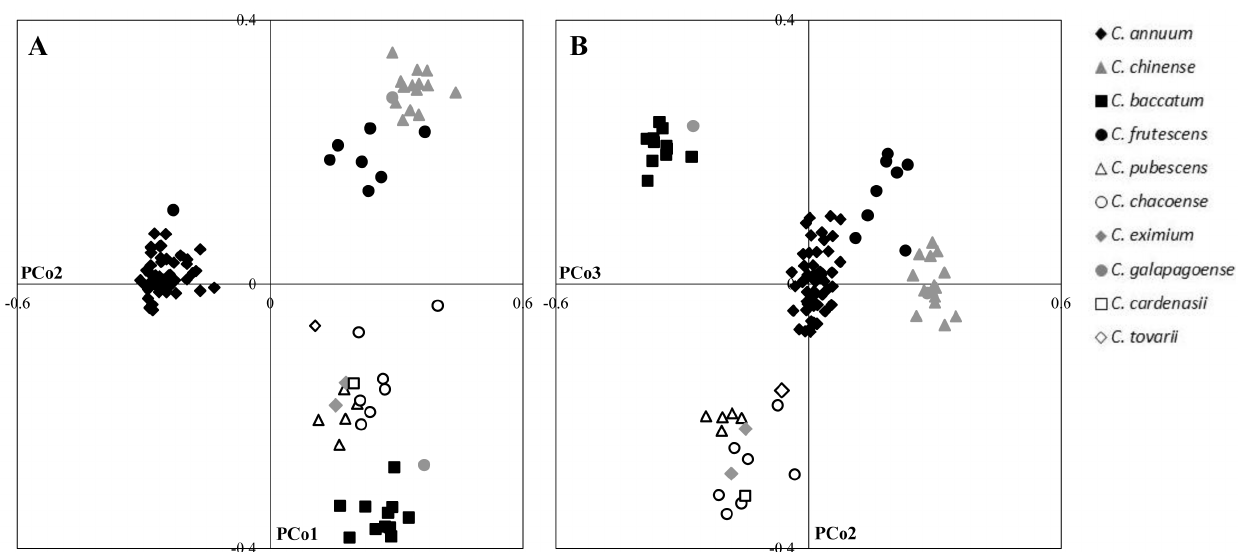
Fig. 2. Principal Coordinate Analysis (PCoA) of 102 Capsicum accessions based on 39 SSR markers. A) Coordinate 1 (PCo1) vs Coordinate 2 (PCo2). B) PCo2 vs